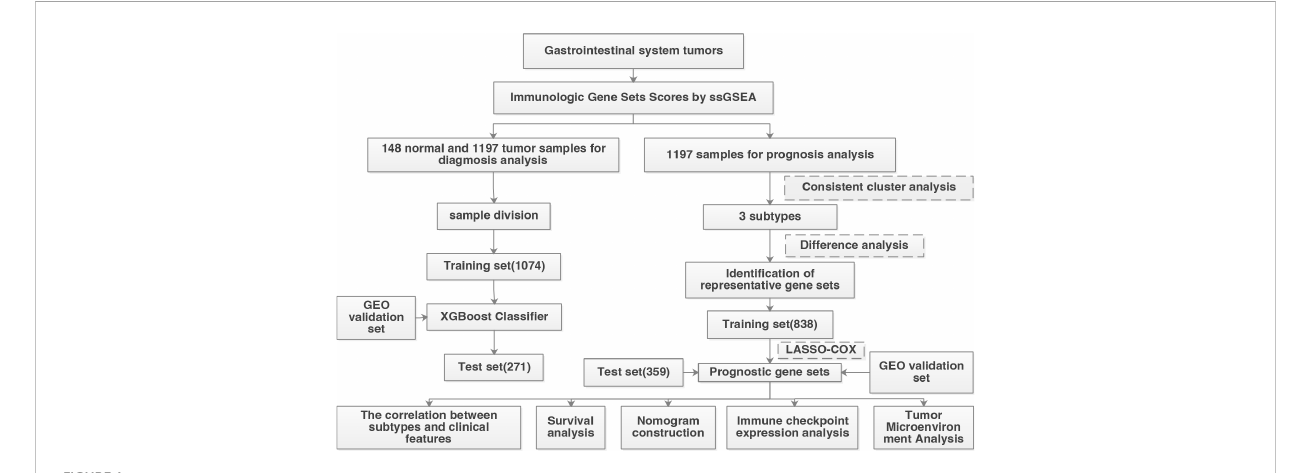
FIGURE 1 Work fl ow of this